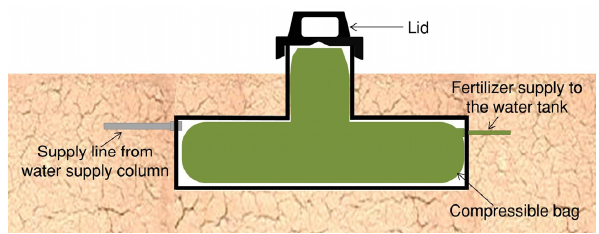
Figure 4. Schematic diagram of fertilizer tank.